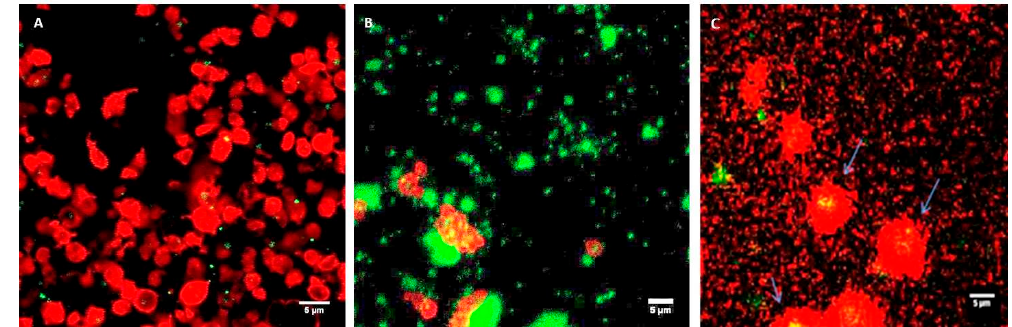
Figure 6. Confocal microscopy images showing ADP ‐ stimulated platelets in PRP (red) incubated with coumarin ‐ labelled PLGA ‐ PEG NPs (green). ( A ) 113 nm; ( B ) 321 nm; ( C ) 585 nm, at 2.2 mg/mL coumarin-labelled PLGA-PEG NPs (green). ( A ) 113 nm; ( B ) 321 nm; ( C ) 585 nm, at 2.2 mg / mL NPs. Platelets in PRP were fluorescently labelled with phalloidin ‐ TRITC at 0.25 mg/mL and fixed using 1% formaldehyde. Magnification ×100, scale bar represents 5 μ m.